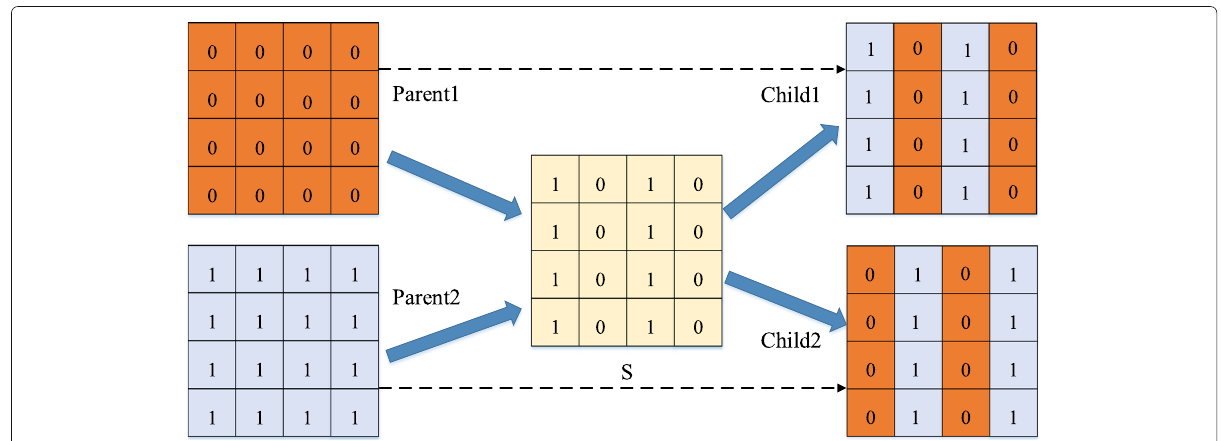
Fig. 3 An example of a multi-point crossover operation